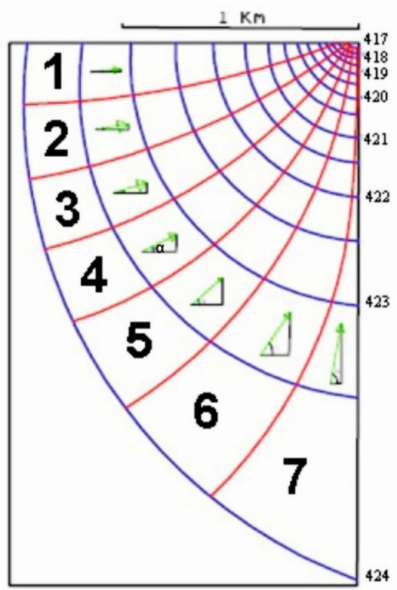
Figure 12. The flow net sketch of the spring zone with the relative vectors of the groundwater flow; the hydraulic parameters obtained from the analysis are duly shown in Table